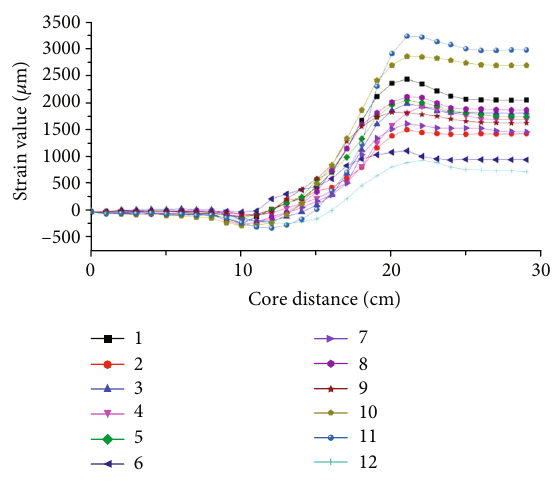
Figure 5: Stress relief curve of no. 1 measuring